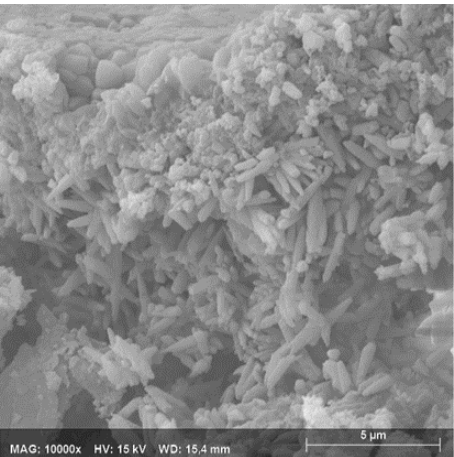
Figure 12. SEM image at high magnification (MAG: 10,000x), with a working distance (WD) of 15.4 mm, at A mortar surface where it is possible to observe the presence of different calcium car- bonate crystals, some with an acicular shape attributed to phenomena of dissolution and reprecipi- tation of the carbonated binder.